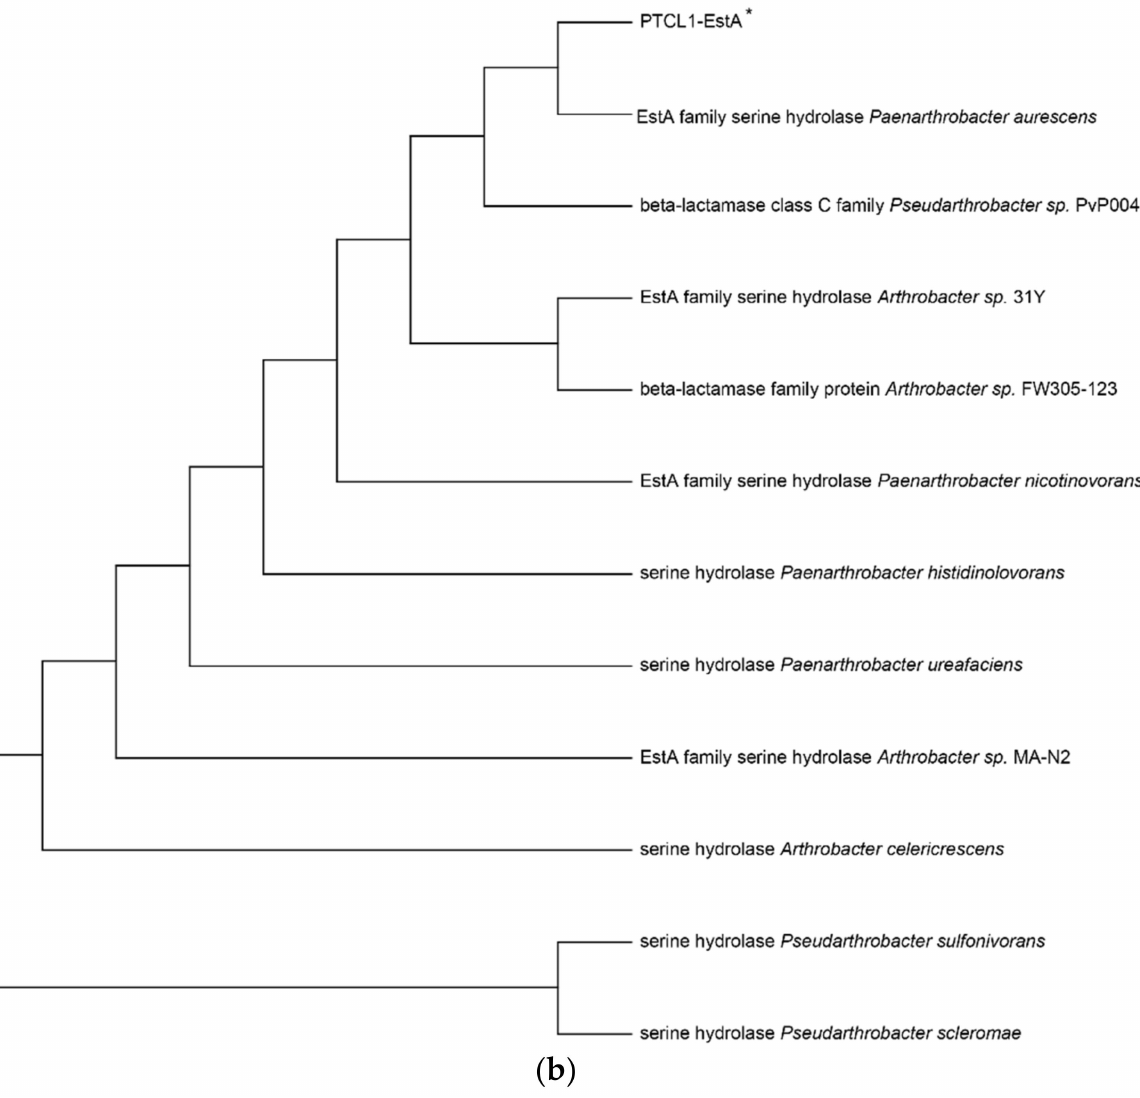
Figure 1. ( a ) Sequence alignment analysis of serine hydrolases from different species; ( b ) Phyloge- netic tree of serine hydrolases from different species. The numbers below the lines represent the evolutionary distance. PTCL1-EstA is marked with